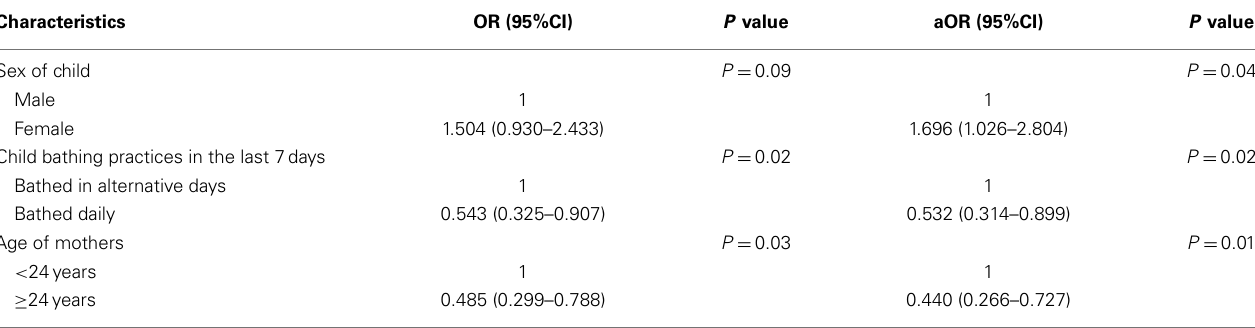
Table 5 | Factors associated with underweight